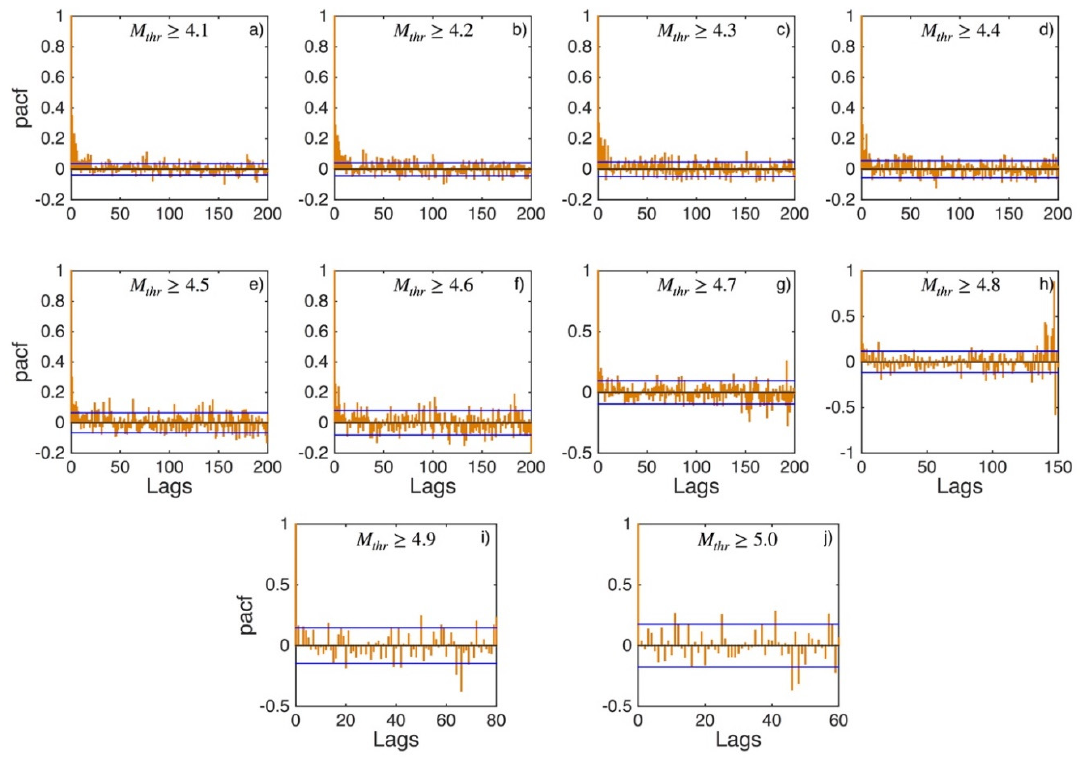
Figure A7. ACF values (red stems) and their 95% confidence intervals (blue lines) for Eastern Hellenic Arc (sub − area 4) for magnitude thresholds ( M thr ) varying from 4.1 to 5.0 (sublots a – j ).